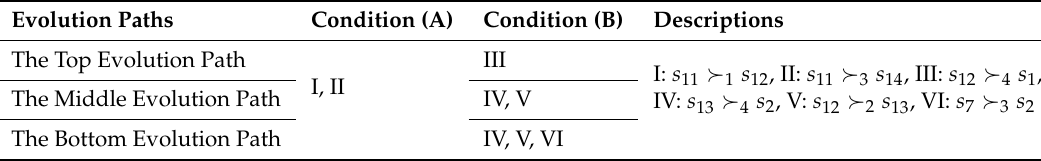
Table 6. Preference statements for ranking